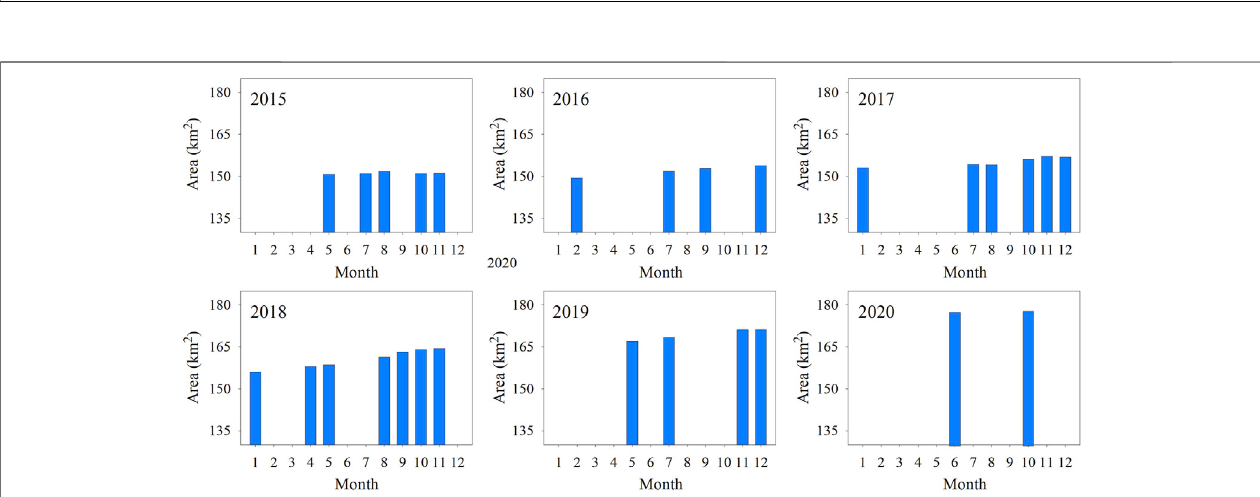
FIGURE 4 | GEE platform-based extraction of the boundaries of Tuosu Lake. The base map is the Landsat OLI image (RGB) acquired in 20 September 2021.